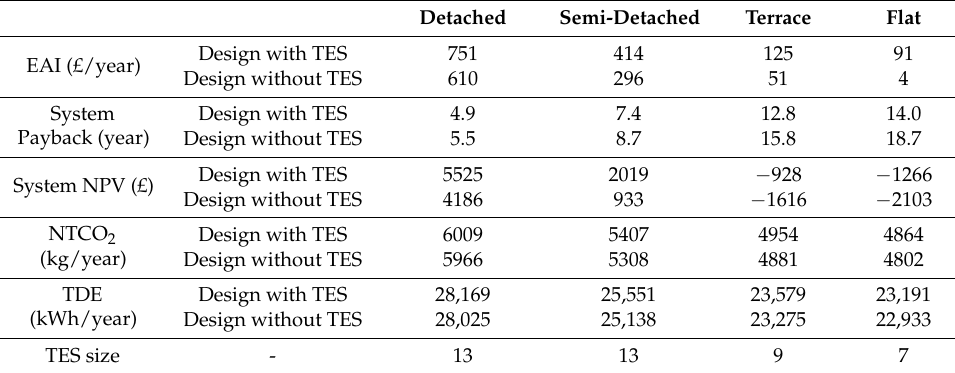
Table 3. Incentivised (FIT) design results.